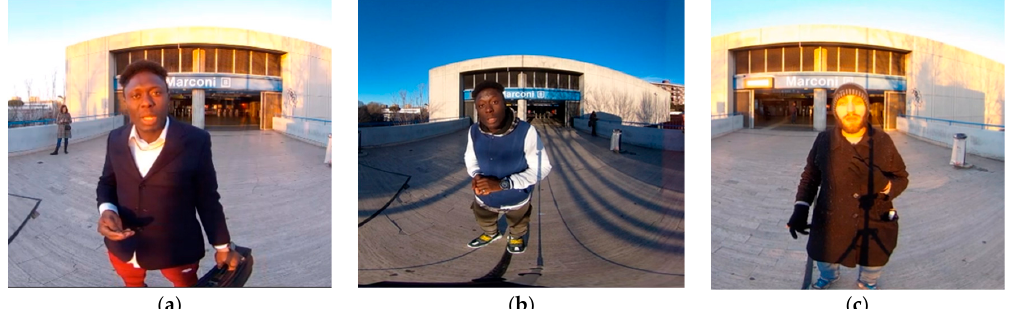
Figure 1. Examples of experimental conditions created by crossing the ethnicity and social appearance of the confederate: ( a ) black confederate dressed as a businessman; ( b ) black confederate dressed casually; and ( c ) white confederate dressed as a beggar.